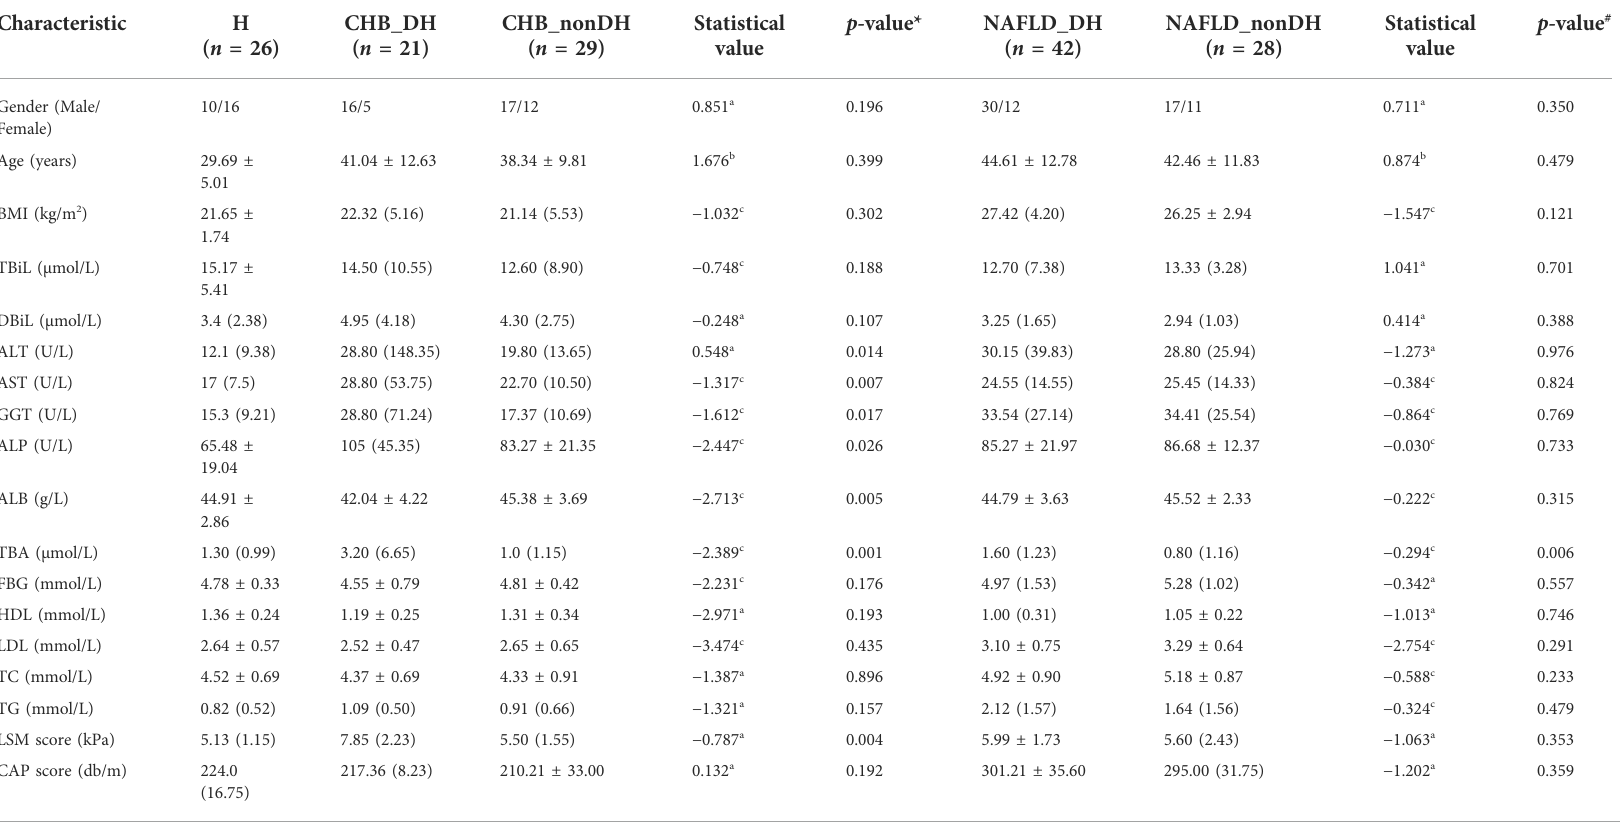
TABLE 1 The basic information of